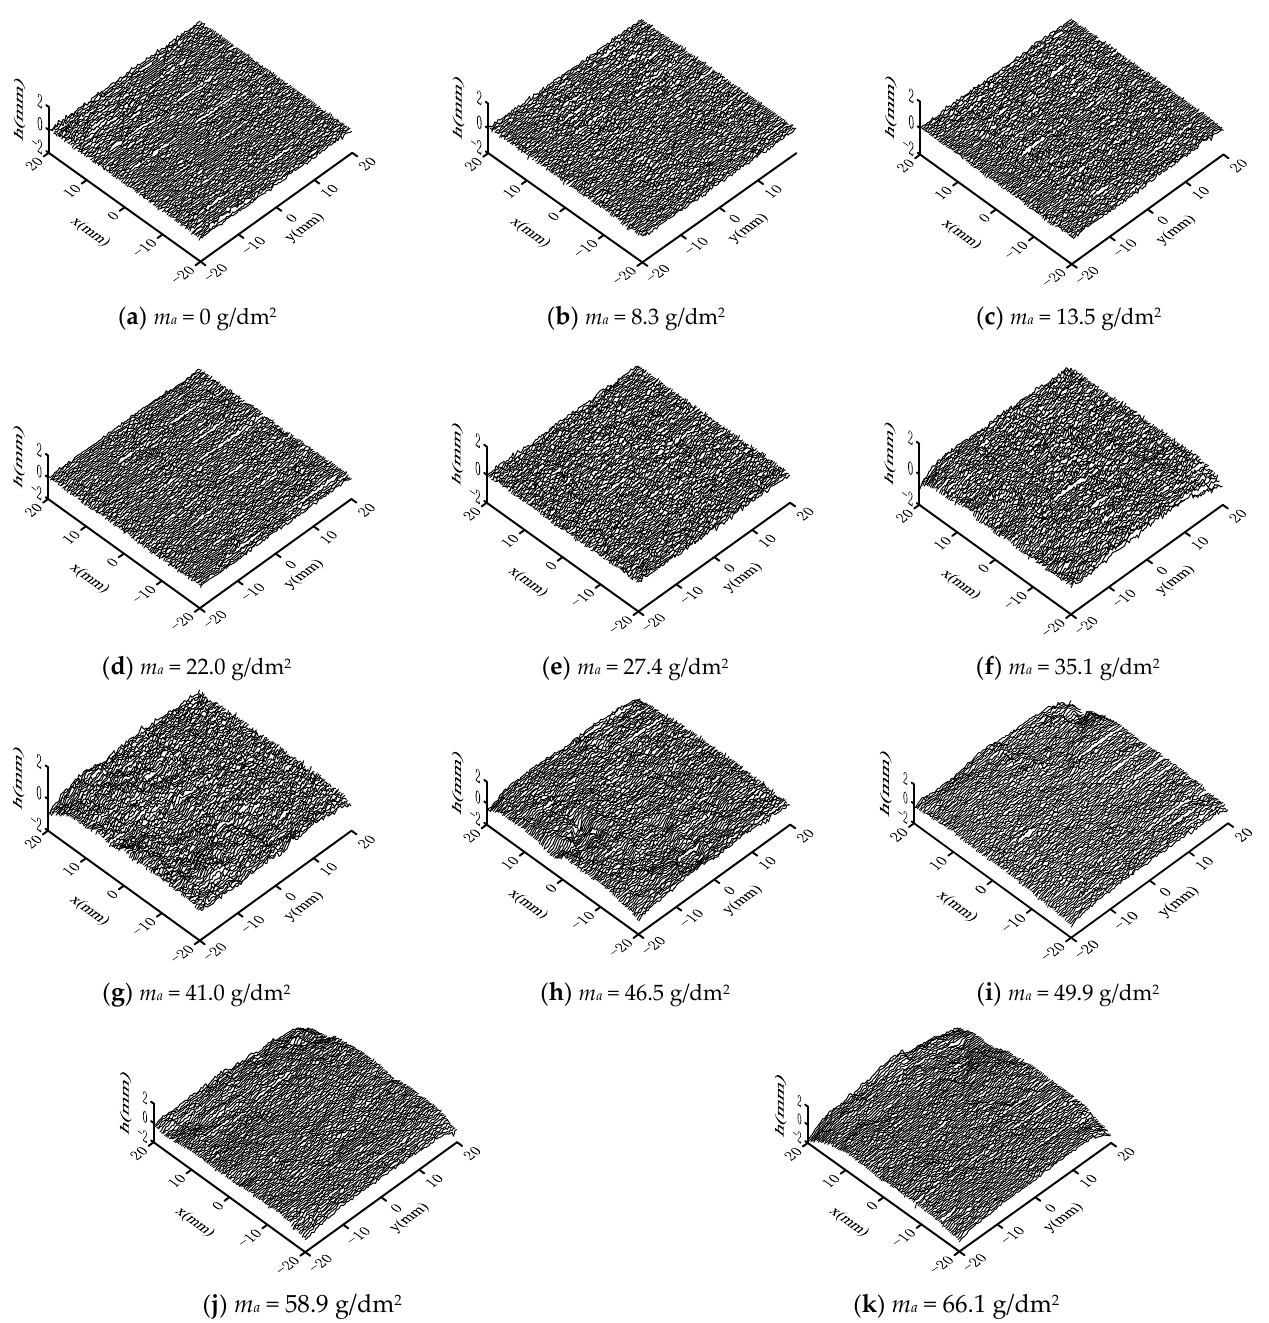
Figure 5. Surface curve maps of corroded steel surface with different corrosion degrees.